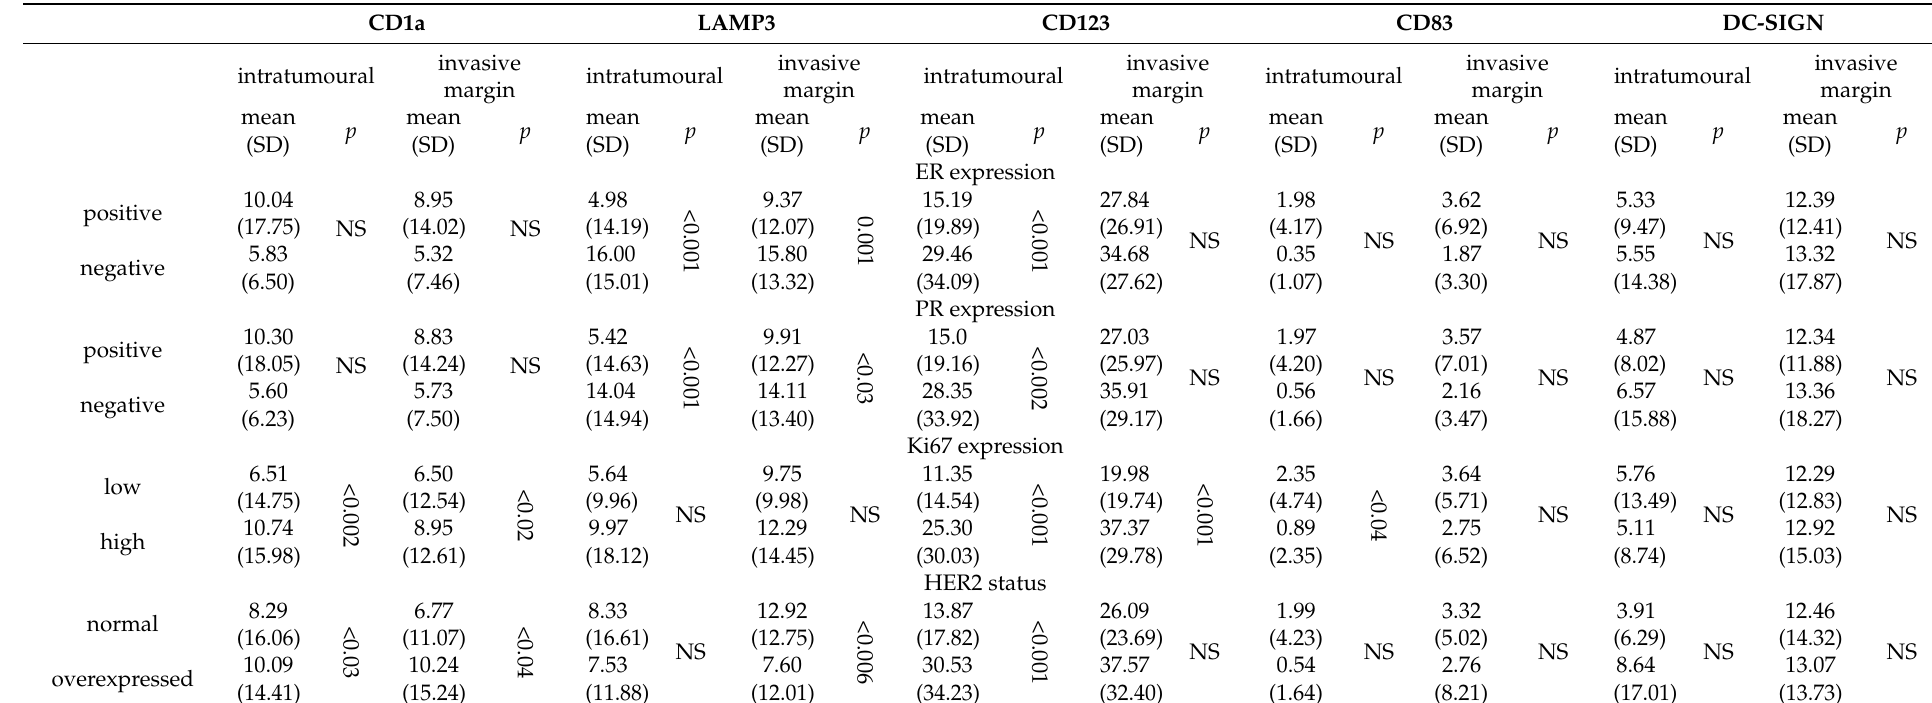
Table 4. DC density in breast cancers of different